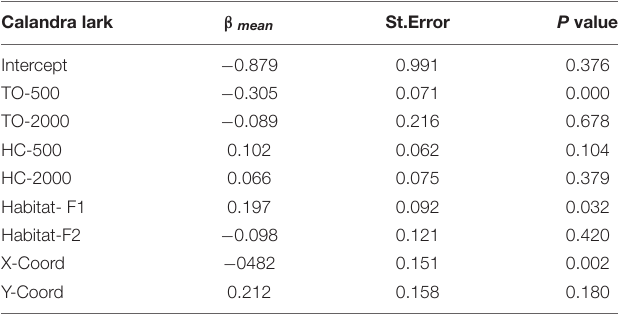
TABLE 5 | Results of the Compound Poisson Generalized Linear Model for the effects of local habitat within transects (Habitat-F1 and F2) and landscape context (around transects) on Calandra lark abundance ( n =